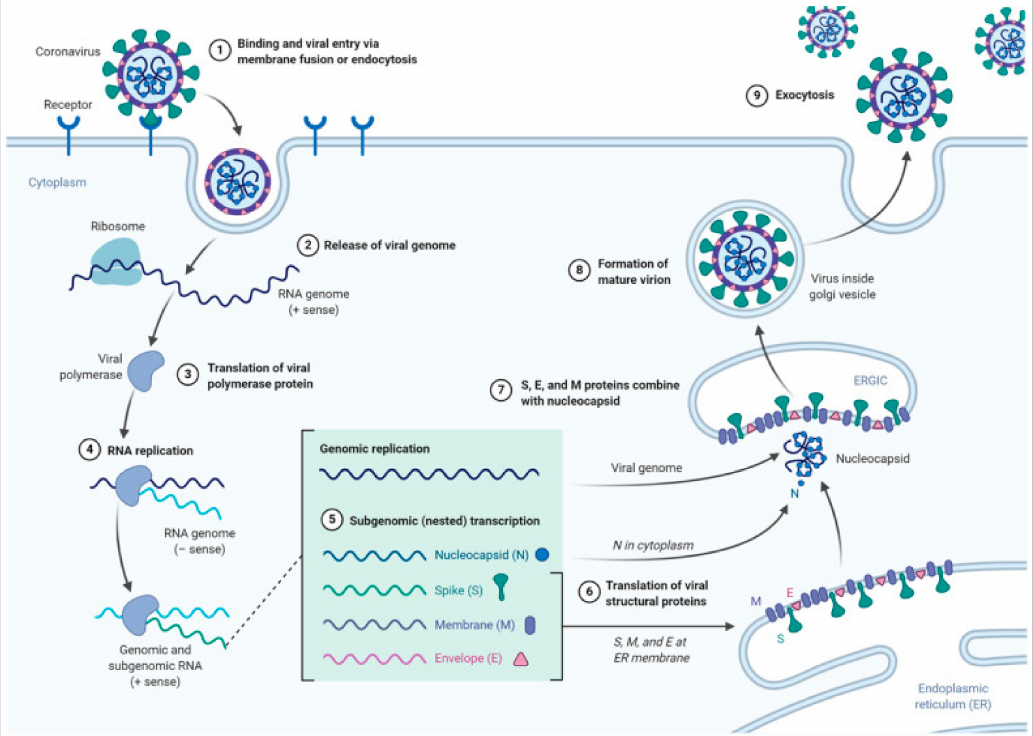
Figure 4. Life cycle of SARS-CoV-2. Virus entry through ACE2 receptor and mechanism of its replication in host cells